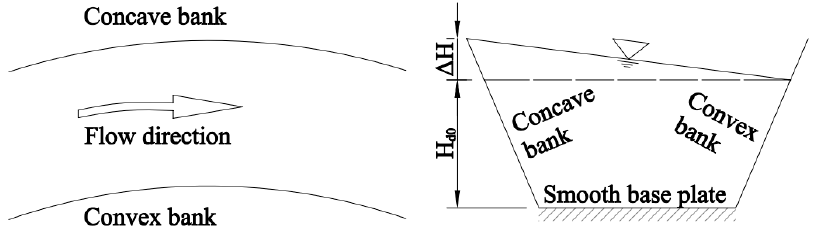
Figure 4. Water levels on the concave bank and convex bank.